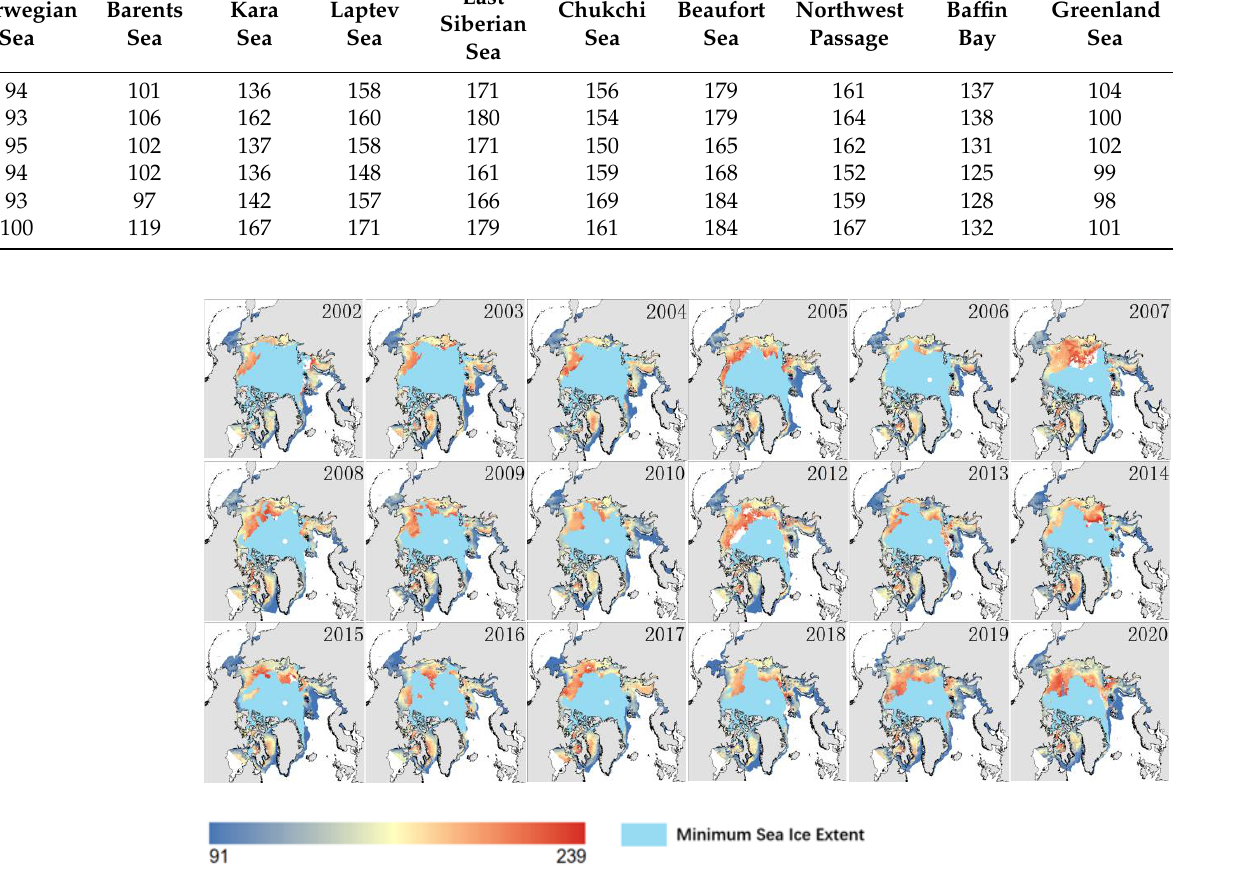
Figure 8. Spatial distribution of Arctic sea ice break-up dates (DoY) from 2002 to 2020. Table 5. DoY of Arctic sea ice complete melt from 2002 to 2020.